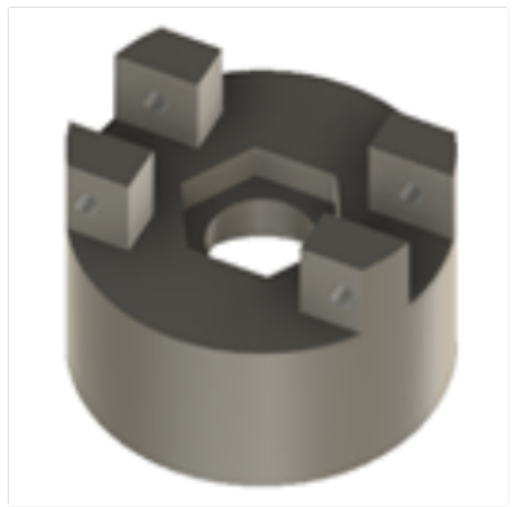
Figure 8. The model of the drill chuck support. The drill chuck support exists at the lower part of the ID component in Figure 3. The drill chuck support is utilized to fix a commercial drill chuck